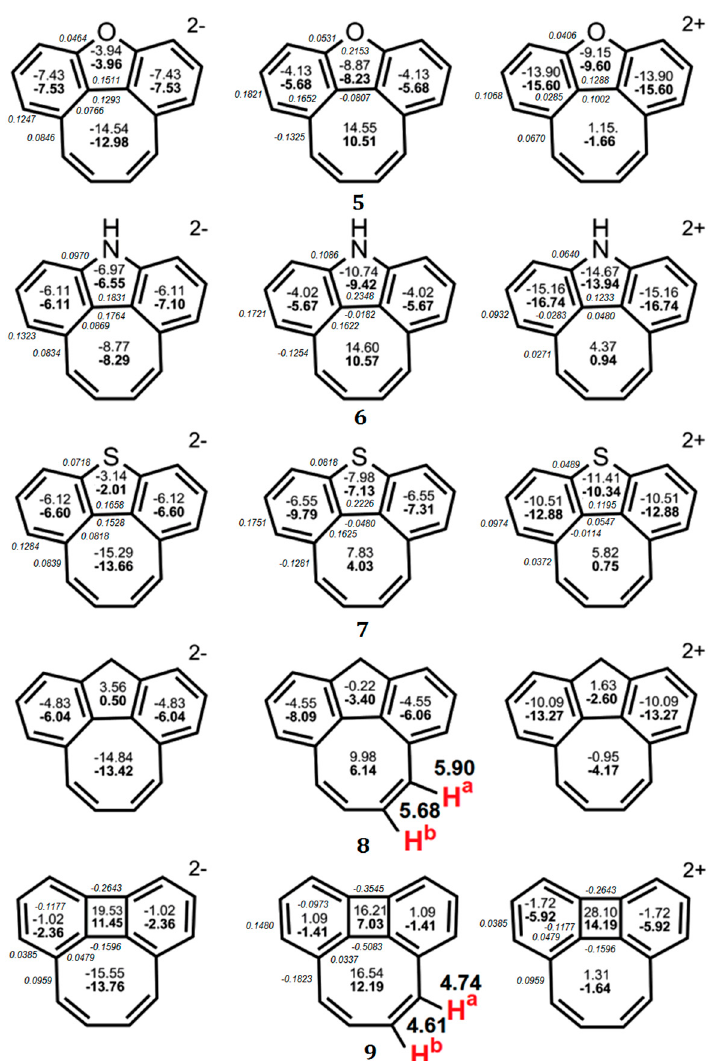
Figure 3. The values of NICS(0) (top number) and NICS(1) (bottom number indicated in bold) indices calculated at the GIAO/B3LYP/6-311++G(d,p) level of the theory for the neutral molecules of quasicirculenes 5 – 9 and their corresponding dianions and dications [50] and experimental values of the 1 H NMR chemical shifts [53,54]. The BREs in units of | β | for the neutral and doubly charged ions of 1 – 4 were taken from Ref. [51] and are presented in italics.